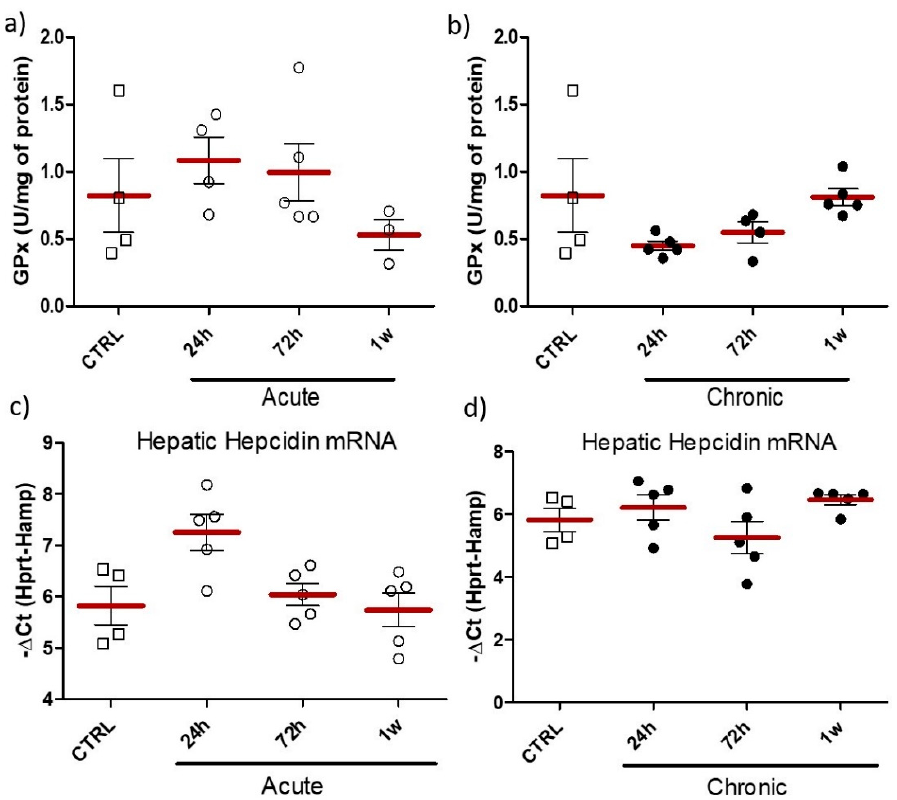
Figure 13. Hepatic activity of glutathione peroxidase in acute ( a ) or chronic simulation ( b ), and mRNA levels of hepatic hepcidin measured with RT-PCR method and normalized to transcripts encoding hypoxanthine-guanine phosphoribosyltransferase genes (Hprt) ( c , d ). Results obtained at different time-points (24 h, 72 h or 1 w) following intra-gastric administration of ZnO:Fe 3+,2+ nanoparticles vs. the control (CTRL). Data presented as mean ( ± SEM) for control ( n = 4) vs. experimental groups (Acute 24 h n = 5; Chronic 24 h n = 5; Acute 72 h n = 5; Chronic 72 h n = 5; Acute 1 w n = 5; Chronic 1 w n = 5). Range presented as squares for CTRL, open circles for acute model and filled circles for chronic model in experimental groups.